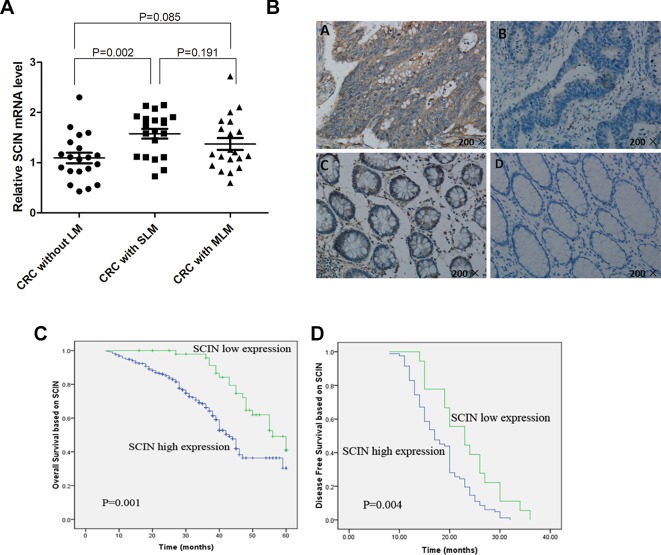
SCIN expression in CRC tissue samples and Kaplan-Meier analysis with OS and DFS. (A) qRT-PCR was used to detect SCIN mRNA expression levels in CRC primary tumor tissues without LM, with SLM, or with MLM. (B) Representative immunostains of SCIN expression in CRC clinical samples. Positive cells are stained brown high-intensity SCIN expression in cancerous tissues (upper left). Low-intensity SCIN expression in cancerous tissues (upper right). Positive SCIN staining in paracancerous tissue (below left). Negative SCIN staining in paracancerous tissue (below right). (C) Kaplan-Meier analysis of OS related to SCIN expression in patients with CRC (n = 300; P = 0.001). (D) DFS (P = 0.004) related to SCIN expression in MLM patients (n = 100).